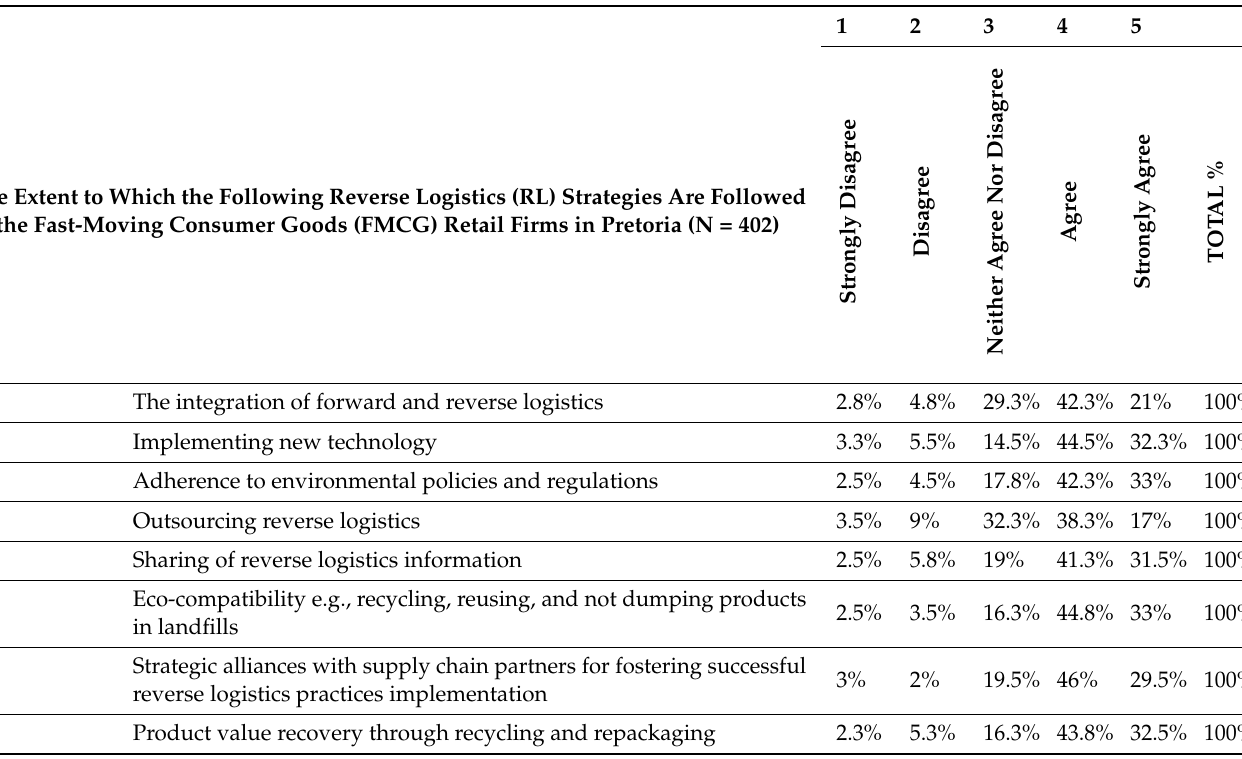
Table 6. RL strategies implemented by FMCG retailers based on customers.